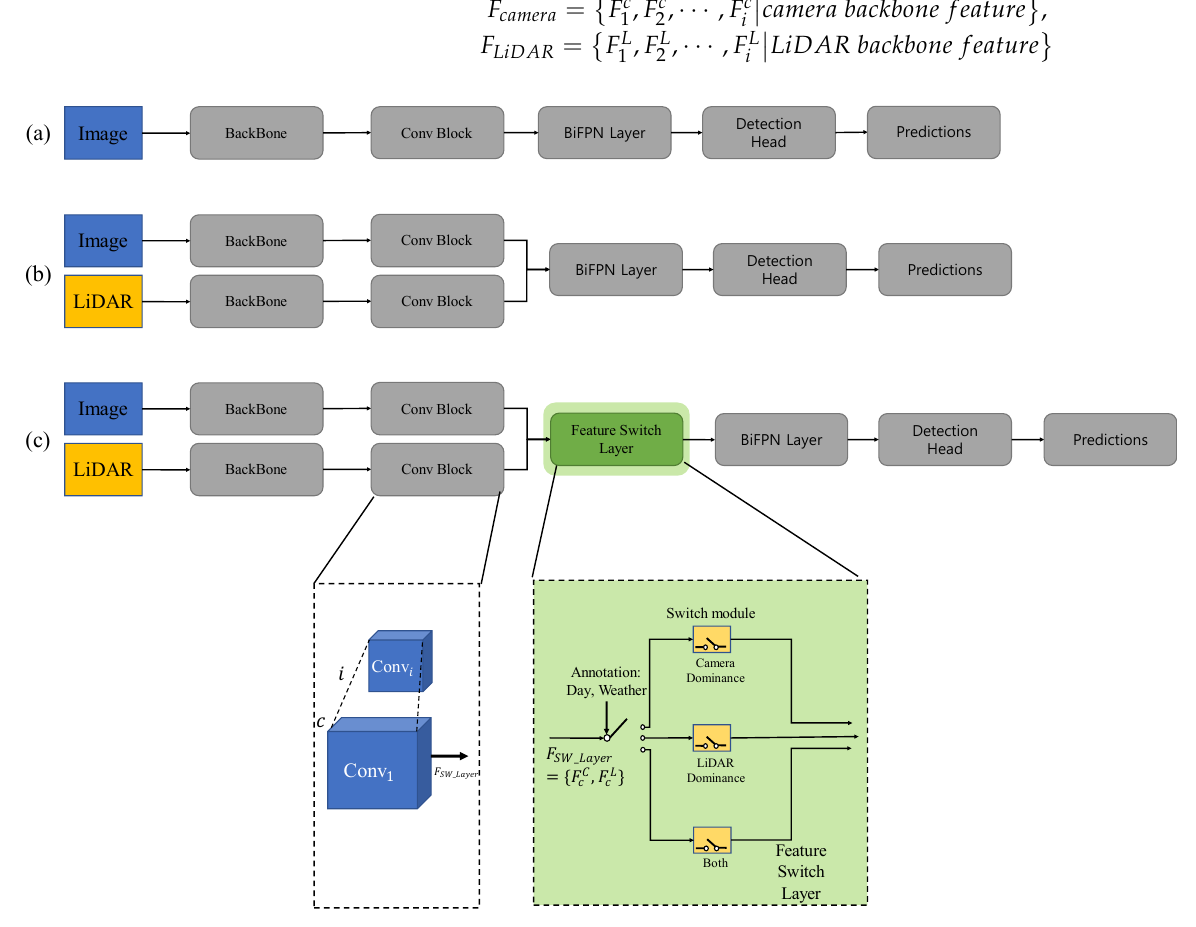
Figure 1. EfficientDet-based network structure. ( a ) EfficientDet [39]; ( b ) EfficientDet fusion method intermediate level; ( c ) EfficientDet with feature switch layer (proposed).